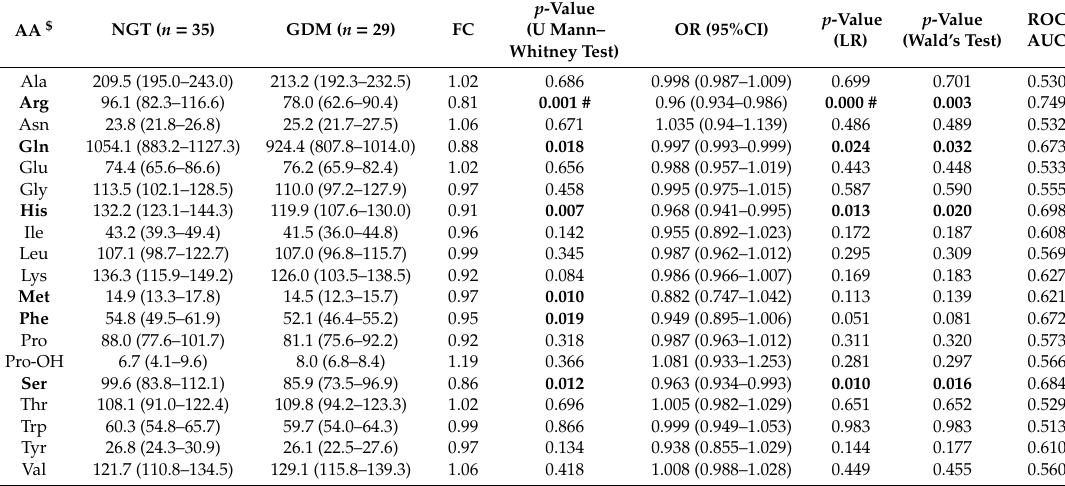
Table 2. Comparison of plasma amino acids concentrations ( µ M / L) in normoglycemic (NGT) pregnant women and GDM pregnant women with logistic regression and ROC curve analysis. Concentration data for compared groups shown as medians and 25–75% quartiles. Fold changes based on medians. Univariate logistic regressions results shown as odd ratios with 95% confidence intervals, considering GDM as a modeled